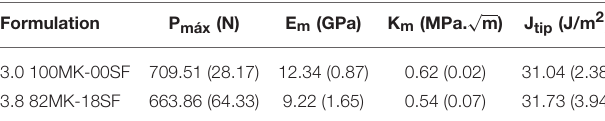
TABLE 4 | Matrix fracture toughness related properties.